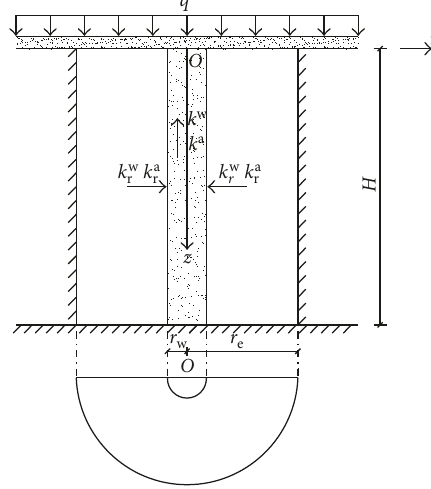
Figure 1: Calculation diagram of vertical drain in an unsaturated soil